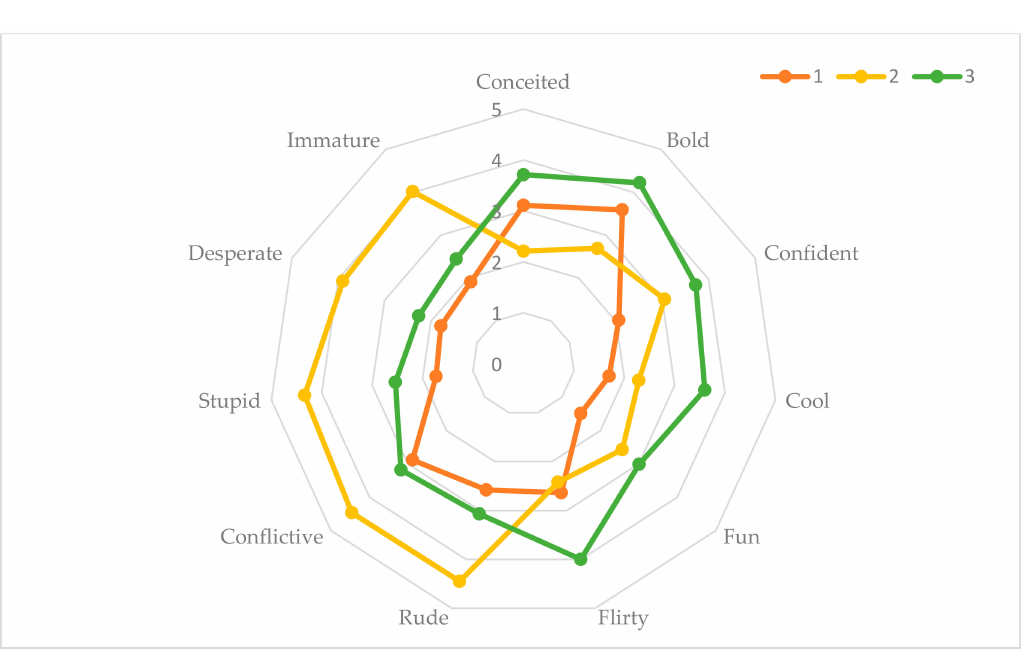
Figure 1. Three identified profiles or clusters according to the rating given by the students as regards